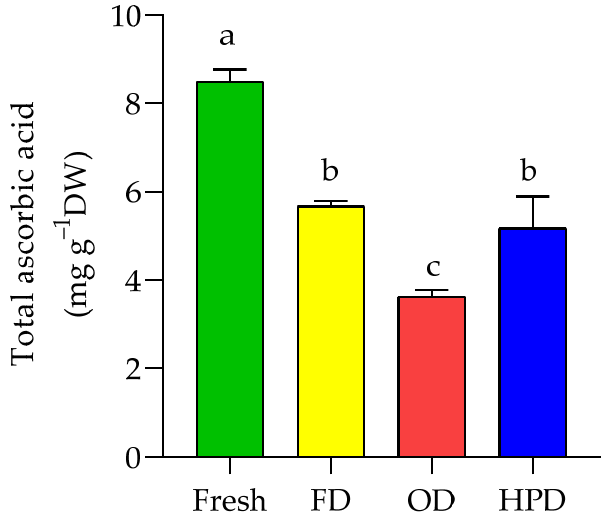
Figure 4. Total ascorbic acid content of U. dioica collected fresh or subjected to three different dry- ing methods. FD: Freeze-drying; OD: Oven-drying; HPD: Heat pump drying. Means keyed with a different letter are significantly different for p = 0.05 following LSD test.